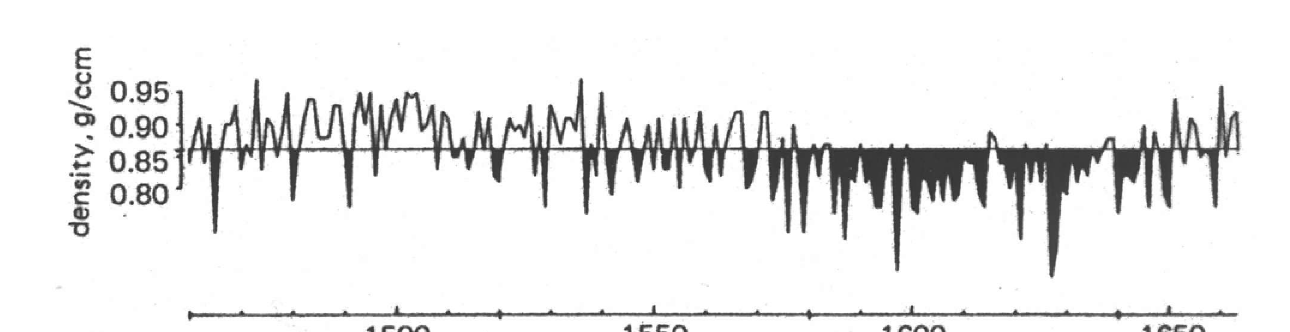
Fig. 1. Vekstkurve for et tre fra Tornetråsk for perioden 1460-1660. Den mørke kurven under linjen for gjennomsnittsvekst gir markerte utslag for begynnelsen av den perioden som i litteraturen gjerne betegnes som "den lille istid" og som varer fra 1550 til 1850. (Kilde: Schweingruber m. fl., 1988: 563). Klima og bestandsdynamikk hos